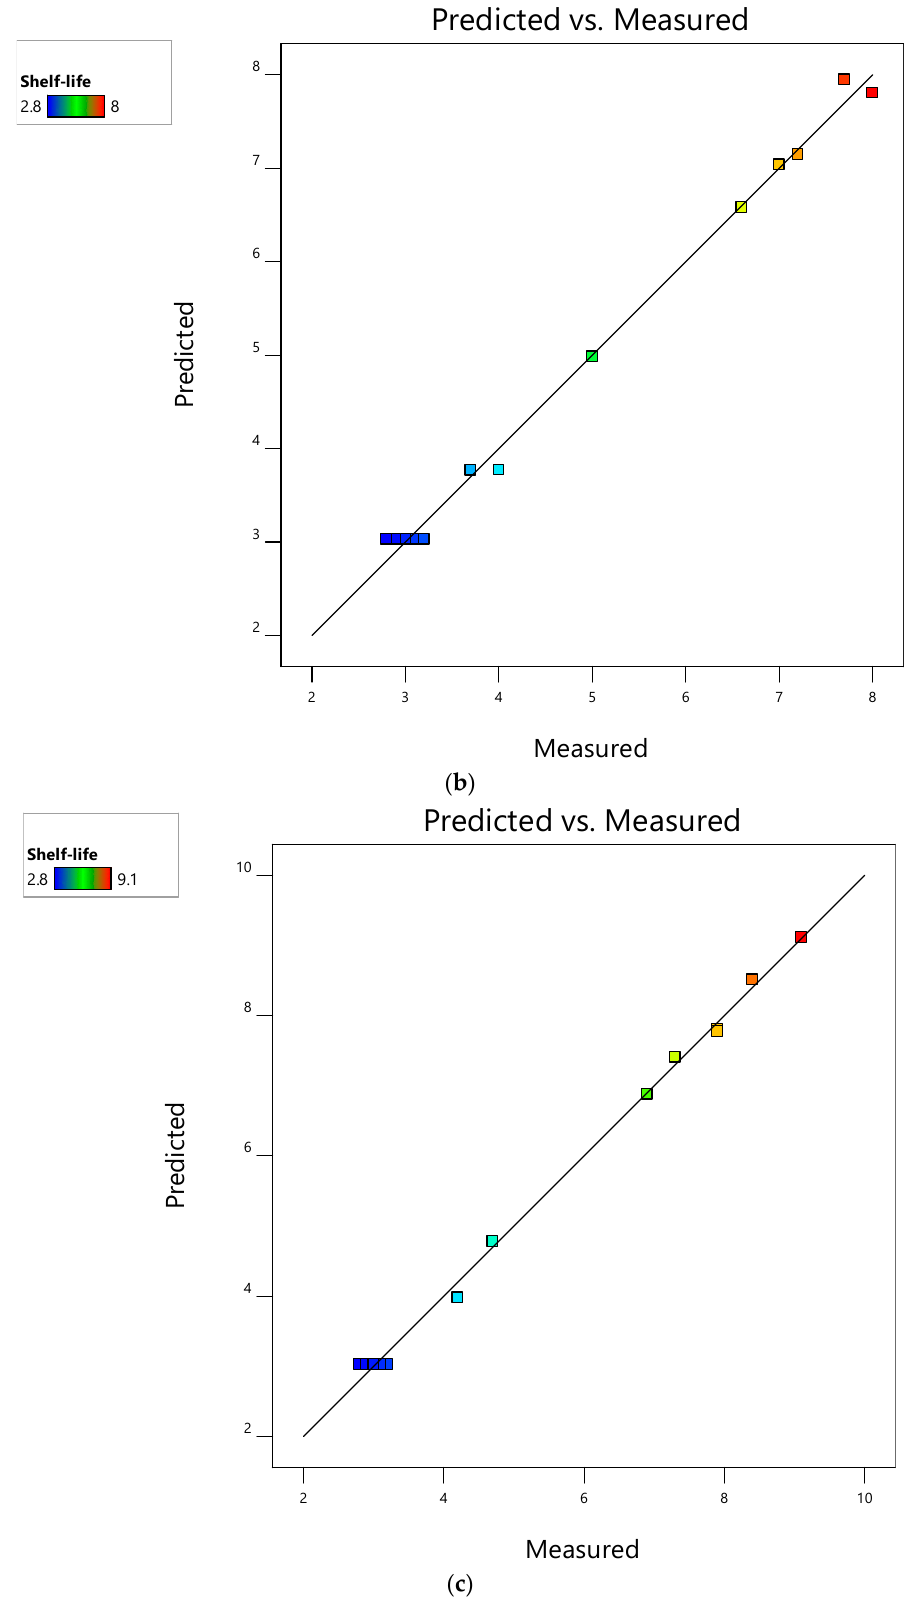
Figure 2. Measured vs. predicted bi-plots for shelf-life extension of mushrooms stored at ambient temperature: ( a ) M 1 (mushrooms of WS and OLPR mixtures), ( b ) M 2 (mushrooms of WS and SCG mixtures), and ( c ) M 3 (mushrooms of WS and OLPR/SCG